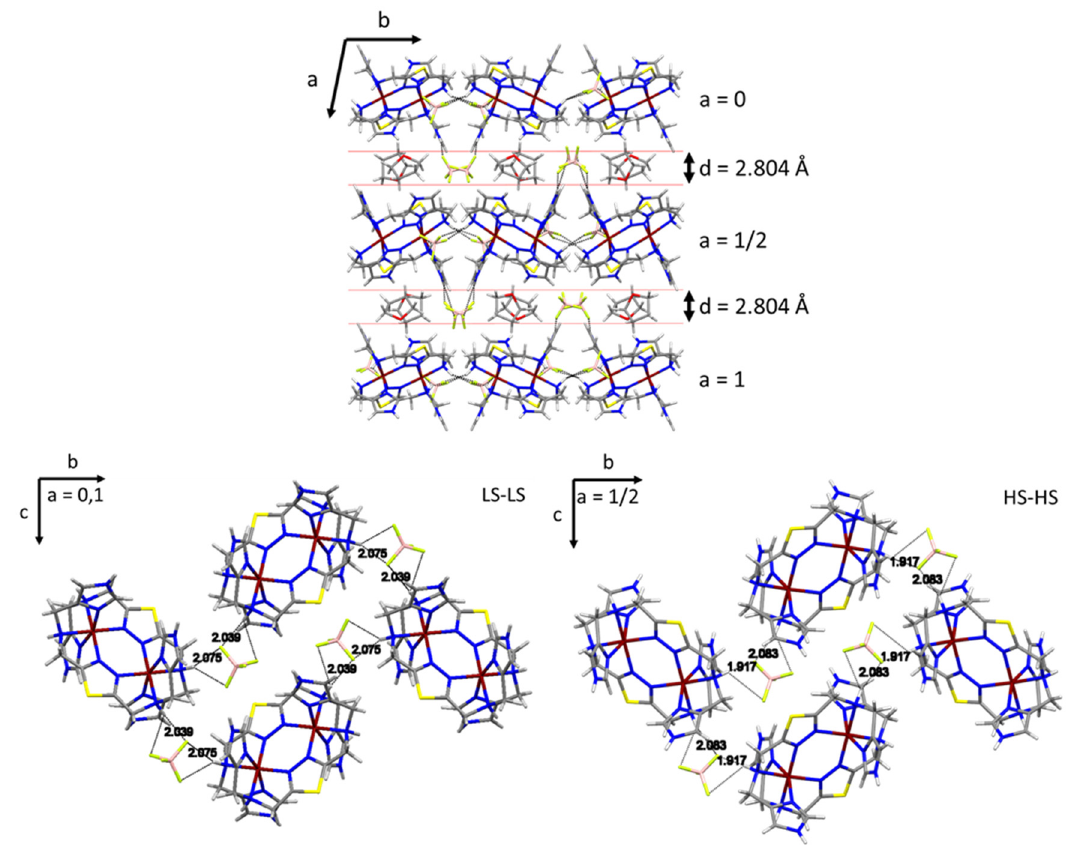
Figure 5. Crystal packing and hydrogen bonding (black dashed lines) toward neighboring anions in C3 ·THF at 100 K (space group P 2 1 / c ). Top. View along the crystallographic c -axis. Bottom. View along the crystallographic a -axis. Left. Layer with only [LS-LS] molecules. Right . Layer with [HS-HS] molecules. Solvent molecules, as well as non-bridging counterions, have been omitted for clarity. Color code: Fe dark red, N blue, S yellow, C gray, B pink, F green and H white.